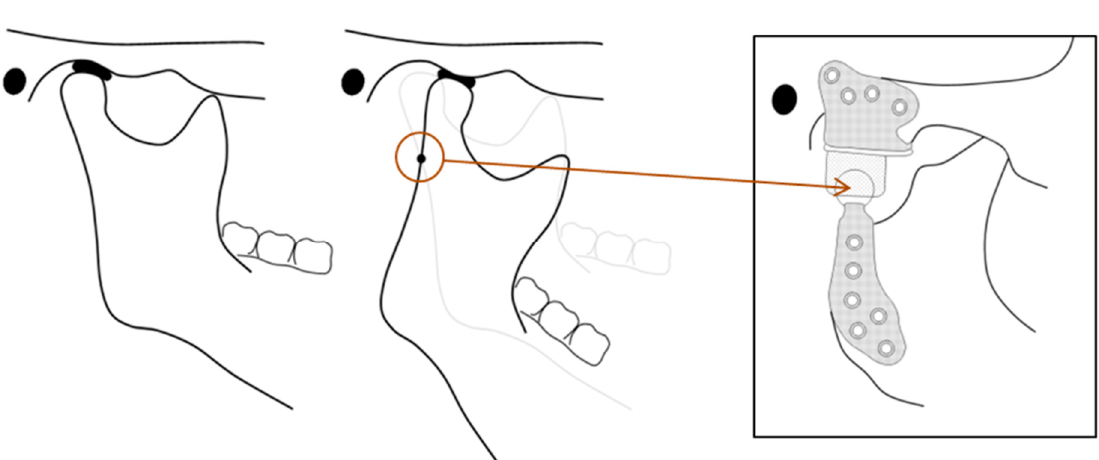
Figure 1. This sketch shows the effect of considering a fixed centre of rotation which is positioned inferior to the centre of the condyle. This lowered centre of rotation mimics the natural translational movement of the condyle whilst merely rotating. The left sketch shows the occlusal mandibular position. Middle shows both the occlusal and maximum opened position of the mandible which is obtained by pure rotation around the dot. The right picture shows the implementation of this effect in the Groningen TMJ-TJR prosthesis, according to the Groningen Principle .